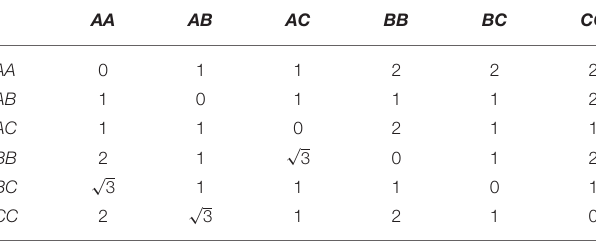
TABLE 4 | Genetic distance assuming diploidy and three codominant alleles.